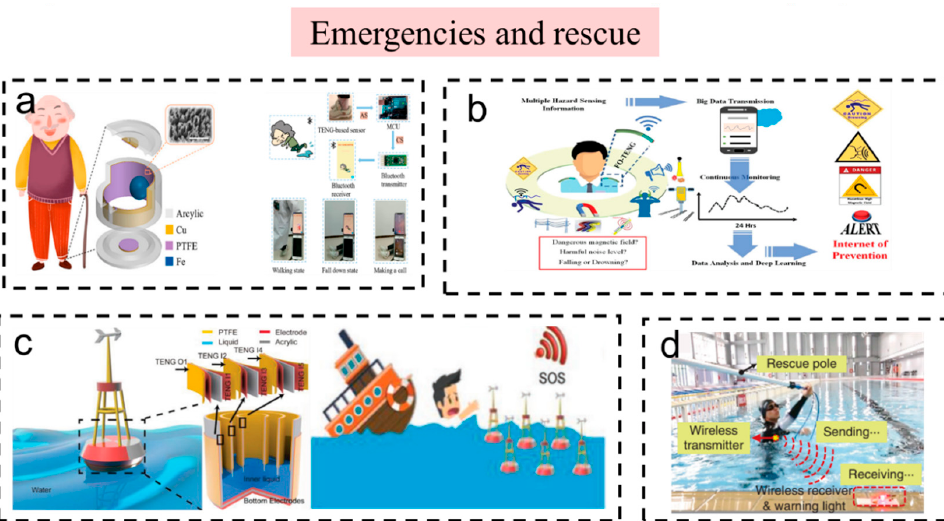
Figure 7. The self-powered wireless sensors and systems based on TENG used in emergencies and rescue. ( a ) Smart Wearable Sensors Based on Triboelectric Nanogenerator for Personal Healthcare Monitoring. Reproduced with permission [99]. Copyright 2021, MDPI (Basel, Switzerland). ( b ) An ultra-shapeable, smart sensing platform based on a multimodal ferrofluid-infused surface. Reproduced with permission [96]. Copyright 2019, John Wiley & Sons. ( c ) A liquid–solid-contact triboelectric nanogenerator and a self-powered wireless save our souls (SOS) system. Reproduced with permission [97]. Copyright 2018, Elsevier Ltd. ( d ) A bionic stretchable nanogenerator for underwater sensing and energy harvesting. Reproduced with permission [98]. Copyright 2019, Springer Nature.